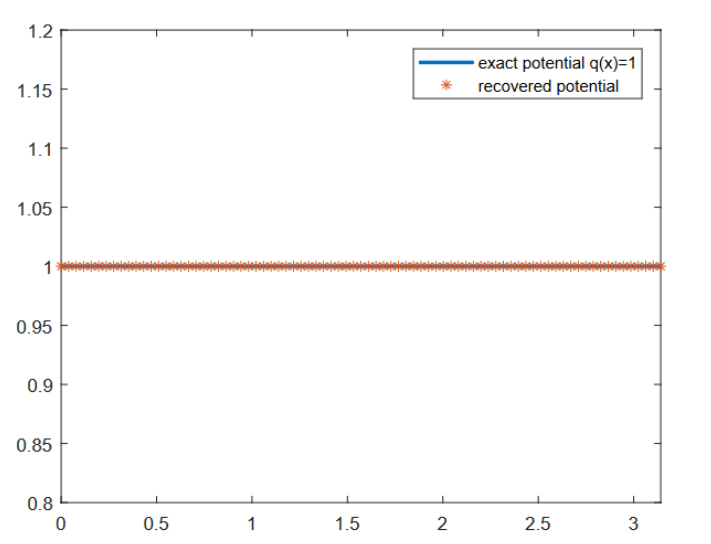
Figure 1. Potential from Example 1 recovered from the Weyl function given at 15 points and with N =